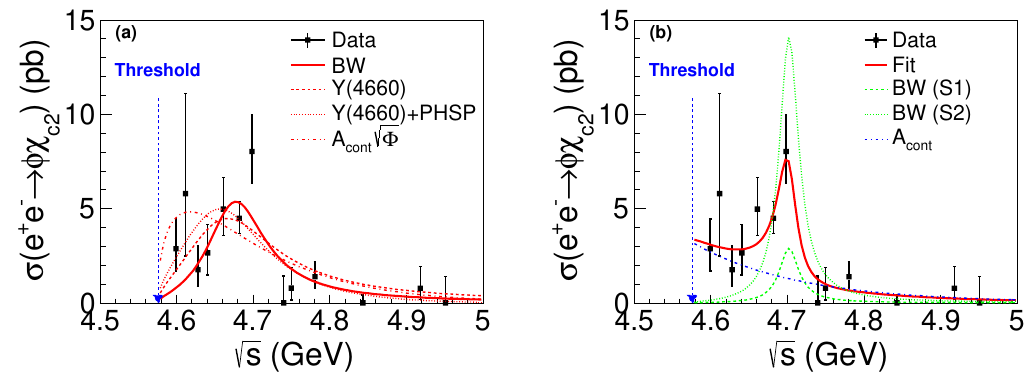
Figure 6 . (a) Fit to the cross section of e + e − → φχ c 2 with a single BW (solid line), the Y (4660) resonance hypothesis (dashed line), the coherent sum of Y (4660) and PHSP (dotted line), and the PHSP corrected continuum amplitude as the non-resonance hypothesis (dash-dotted line). (b) Fit to the cross section of e + e − → φχ c 2 with the coherent sum of a BW and continuum amplitude. The solid line is the fit result, the dashed and dotted lines correspond to the BW with constructive (S1) and destructive (S2) solutions of interference, and the dash-dotted line is the continuum term.